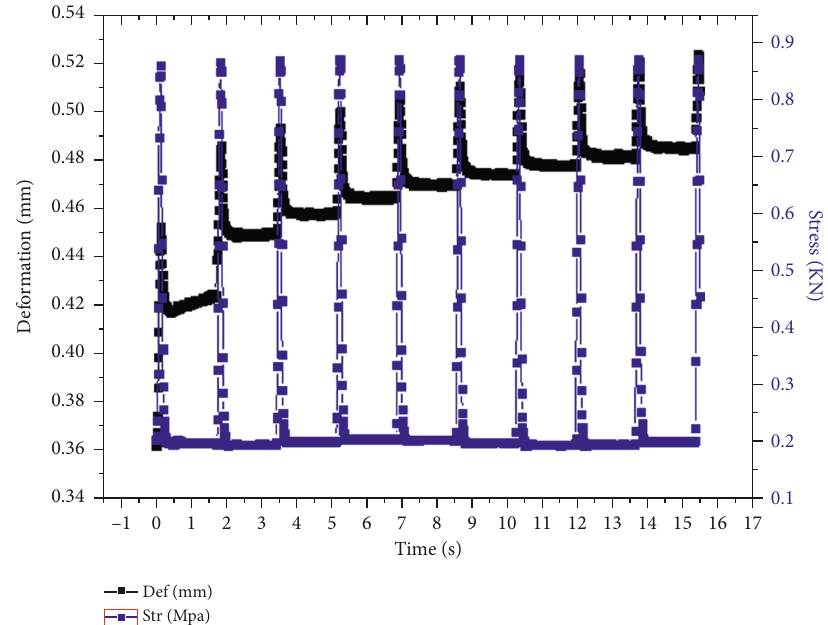
Figure 3: The measured stress-strain diagram of a periodic half-sine pulse load.